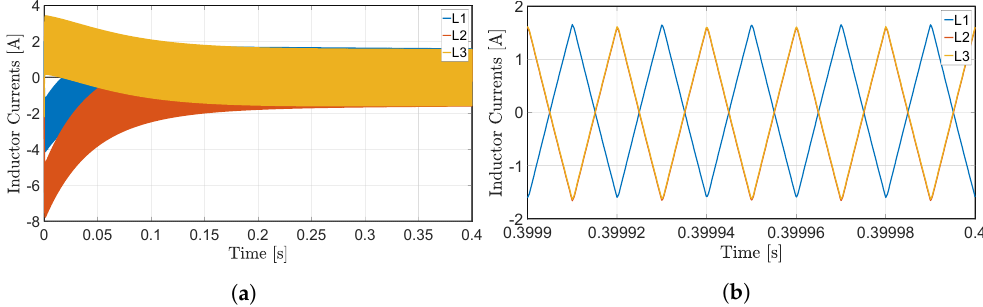
Figure 8. ( a ) Inductor currents of buck-boost balancing circuit in transient; and ( b ) inductor current of buck-boost balancing circuit in steady